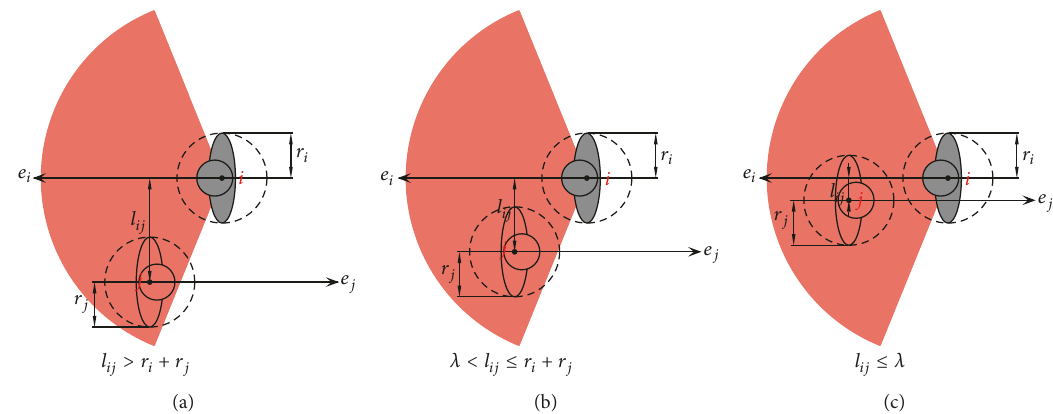
Figure 7: Three types of relative positions between pedestrians (𝑙 𝑖𝑗 ) . In (a) |𝑙 𝑖𝑗 | > 𝑟 𝑖 + 𝑟 𝑗 , there is no potential conflict between pedestrians. In (b) 𝜆 < |𝑙 𝑖𝑗 | ≤ 𝑟 𝑖 + 𝑟 𝑗 , this relative position is the “brush past” case. In (c) |𝑙 𝑖𝑗 | ≤ 𝜆 , this relative position is the “face-to-face” case.